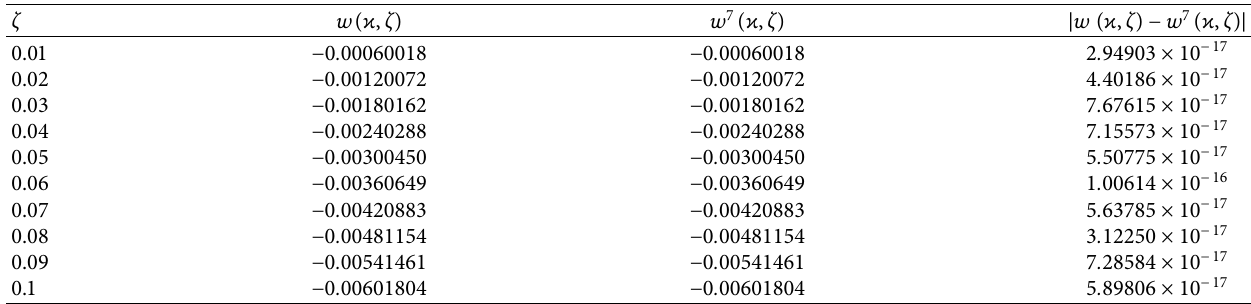
Table 10: | w ( ϰ , ζ ) − w 7 ( ϰ , ζ )| of Problem 2 at ϰ � 1 . 0 when ϖ � 1 . 0 determined by LRPSM at plausible locations in the range ζ ∈ [ 0 , 0 . 1 ]